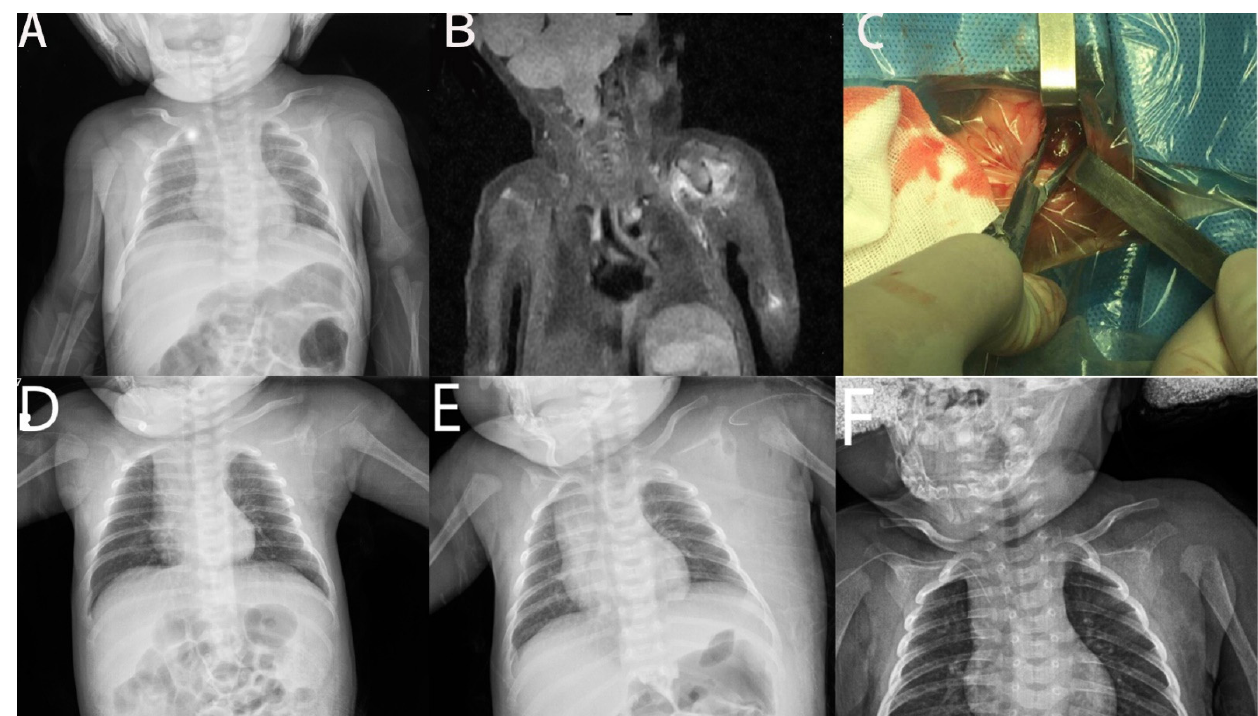
Figure 3. Humeral epiphyseal osteomyelitis and septic arthritis of shoulder joint of 12-day girl. ( A ). AP view of shoulder joint. ( B ). MR image of shoulder joint. ( C ). Intraoperative image of decompression and drainage. ( D ). AP view of shoulder joint at 1st month follow-up. ( E ). AP view of shoulder joint at 3rd month follow-up. ( F ). AP view of shoulder joint at 12th month follow-up.